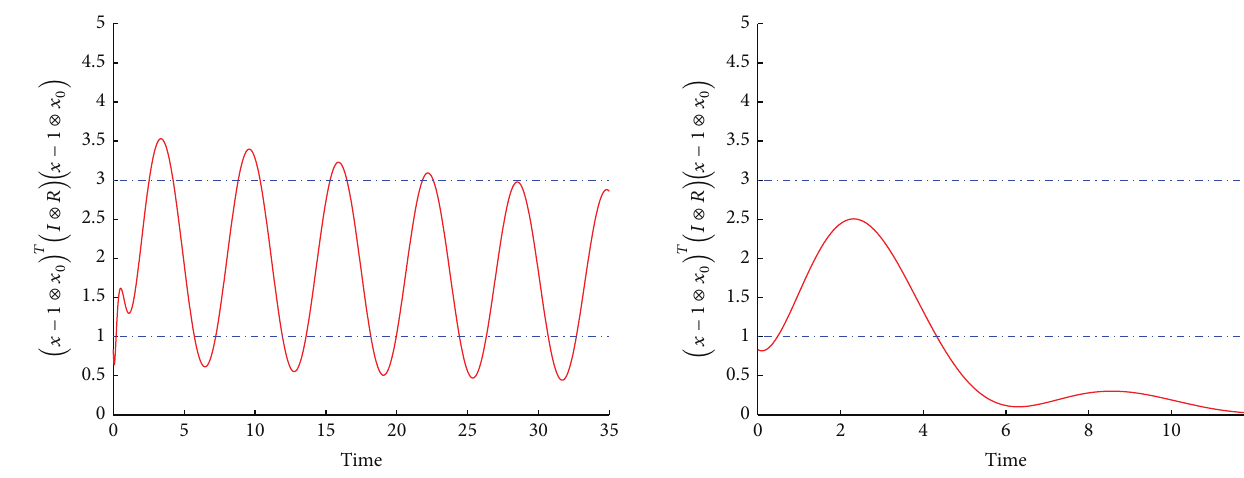
Figure 4: The error trajectories between the leader and each